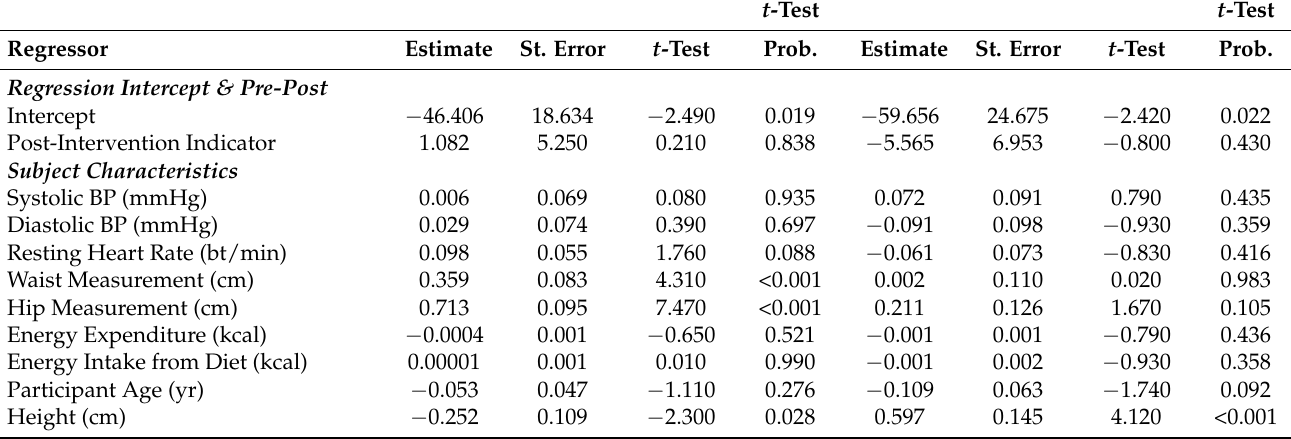
Figure 5. Variation of miRs levels of responders and non-responders to the diet and exercise intervention, * p < 0.05. The responders and non-responders were identified by calculating the % weight loss: ( a ) miR-140; ( b ) miR-935; ( c ) miR-let-7b; and ( d ) miR-99a. Table 3. Ordinary Least Squares regression analysis. t -Test t